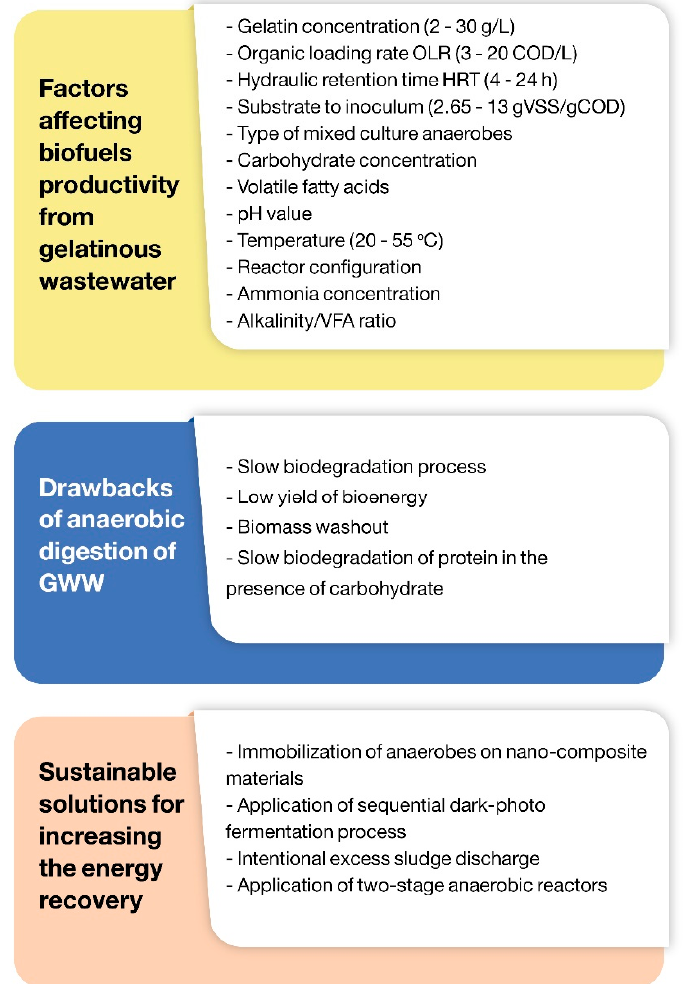
Figure 6. Factors affecting biofuels productivity from gelatinous wastewater, barriers of application of anaerobic digestion process for GWW, and the sustainable solutions for improving the energy recovery.